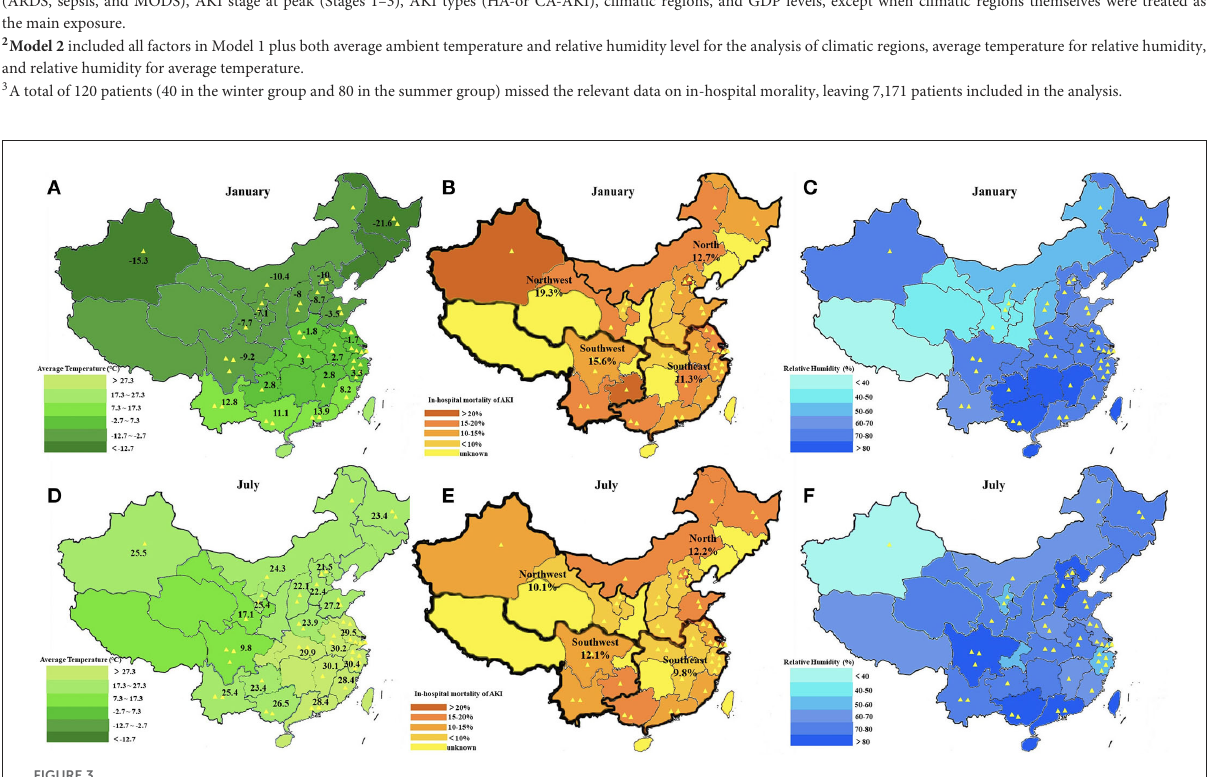
Characteristics of patients with AKI in different seasons The mean age of all-type patients with AKI was 61.5 ± 18.9 years of age, and 65% of the patients were men (Table 2). Patients hospitalized in winter were older (62.5 ± 18.1 vs. 60.0 ± 17.0, p < 0.001) and had higher proportions